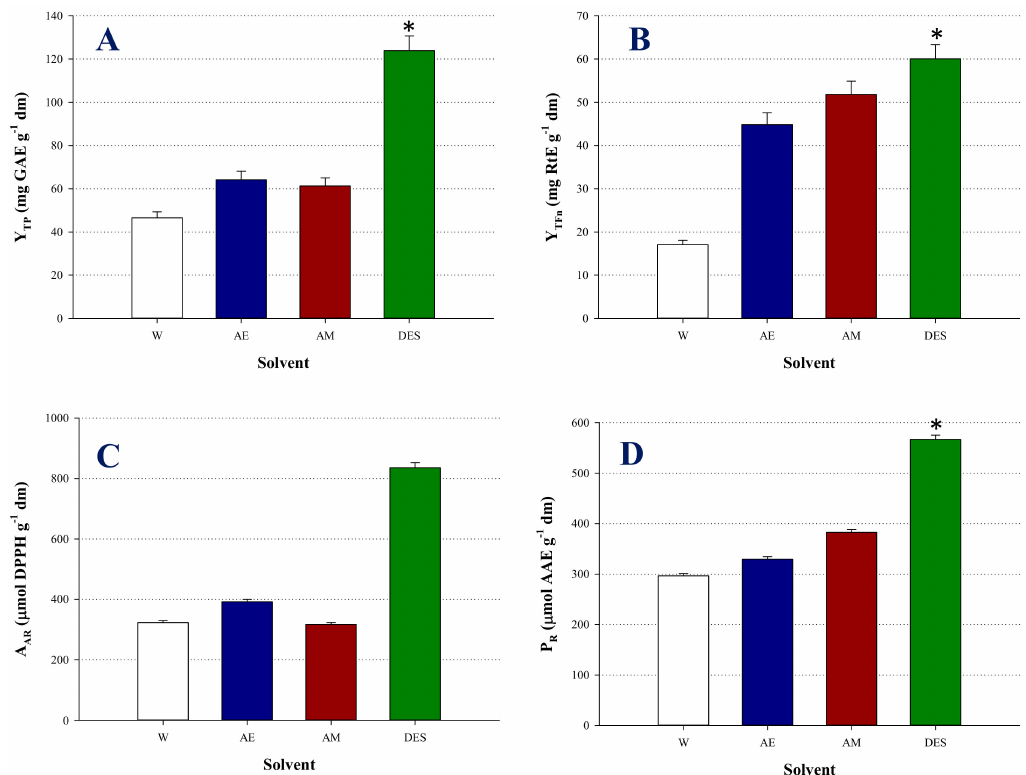
Figure 2. Bar diagrams displaying characteristics of the extracts produced with DES, as compared with control solvents. ( A ), yield in total polyphenols (Y TP ); ( B ), yield in total flavonoids (Y TFn ); ( C ), antiradical activity (A AR ); ( D ), reducing power (P R ). Extractions were performed with C DES 70% ( w / v ), R L / S 35 mL g − 1 , at 50 ◦ C and 500 rpm, for 150 min. Asterisk (*) indicates statistically di ff erent value ( p < 0.05).